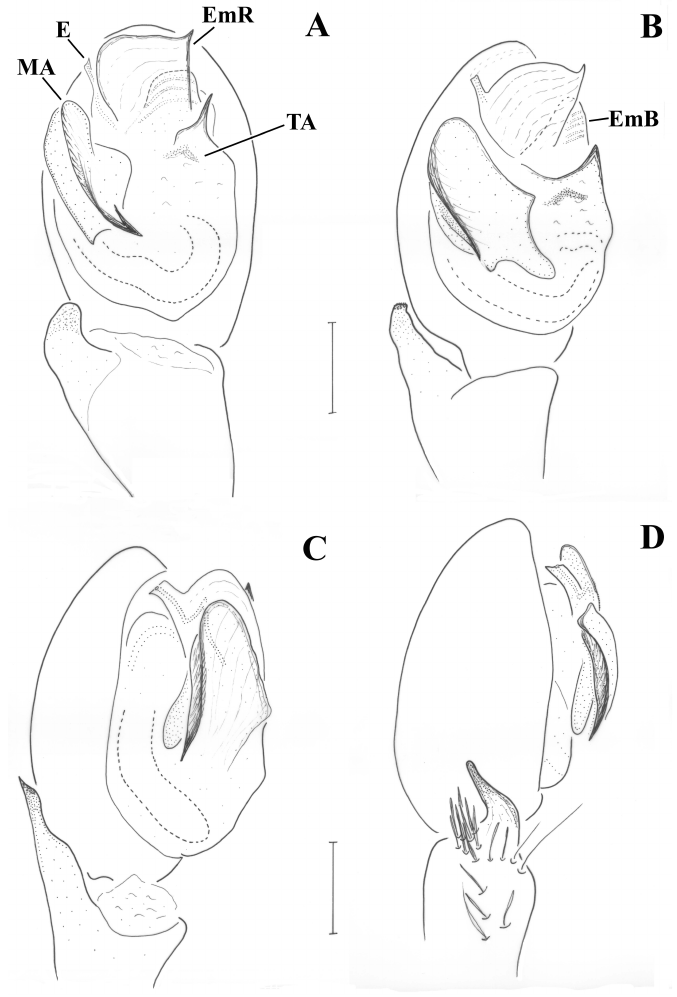
Figure 2. Civizelotes akmon n.sp. (holotype), male pedipalp. ( A ) ventral view, ( B ) ventral to retrolateral view, ( C ) retrolateral view, ( D ) retrolateral to dorsal view. E: embolus, EmR: embolar radix, MA: median apophysis, TA: terminal apophysis.